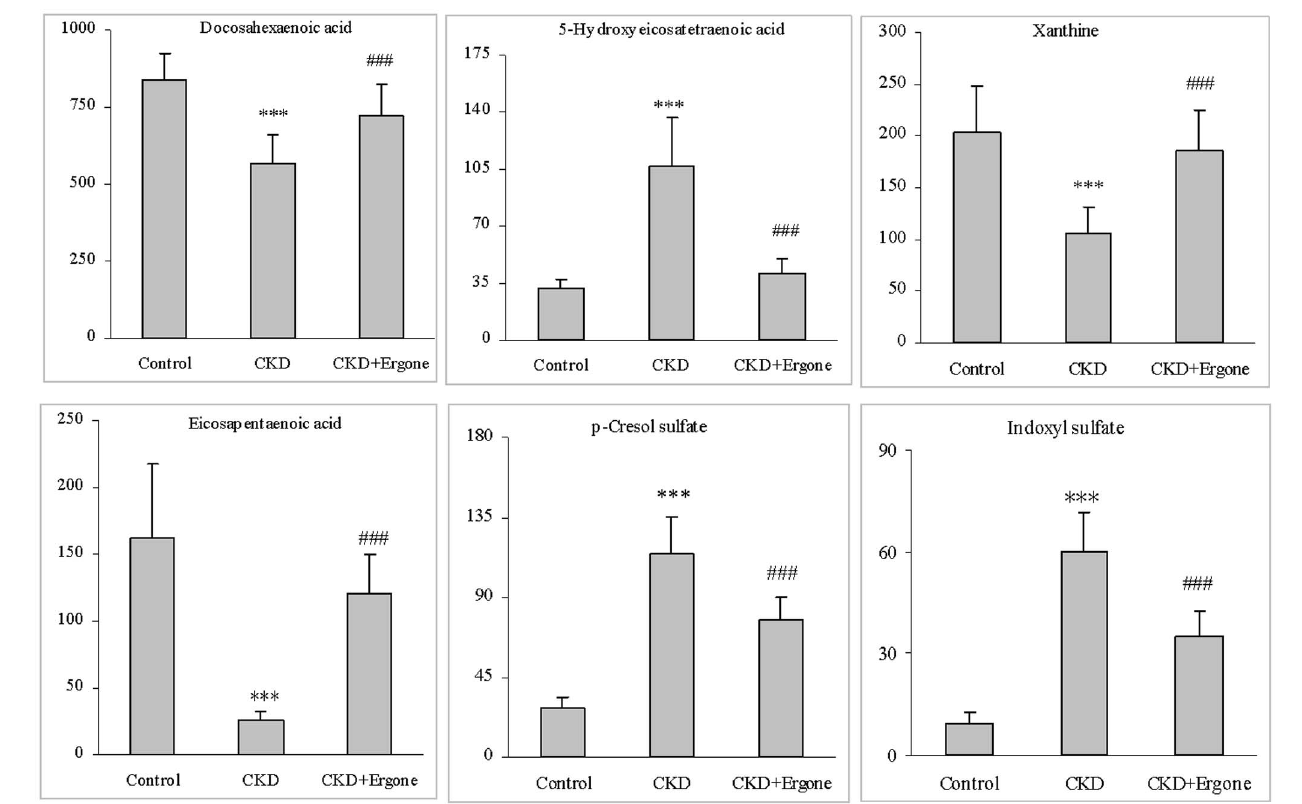
Fig. 4. Change trend of identified biomarkers and Therapeutic effect of ergone. Six identified biomarkers completely reversed by treatment with ergone. * P , 0.05, ** P , 0.01, *** P , 0.001 significant difference compared with control group; # P , 0.05, ## P , 0.01, ### P , 0.001 significant difference compared with CKD